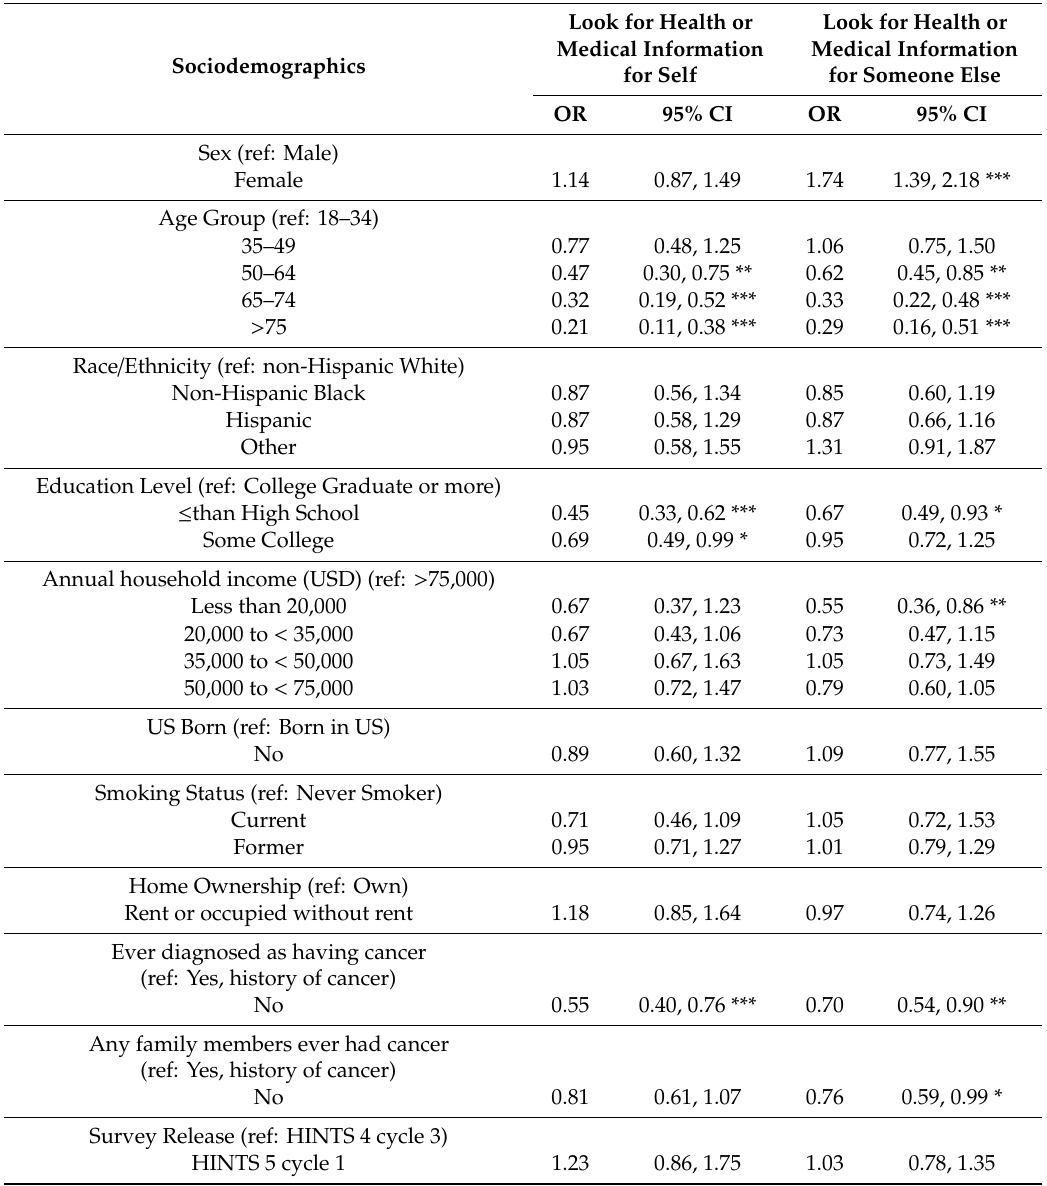
Table 4. Results of multivariable logistic regression models for health information seeking domain outcomes ( N =